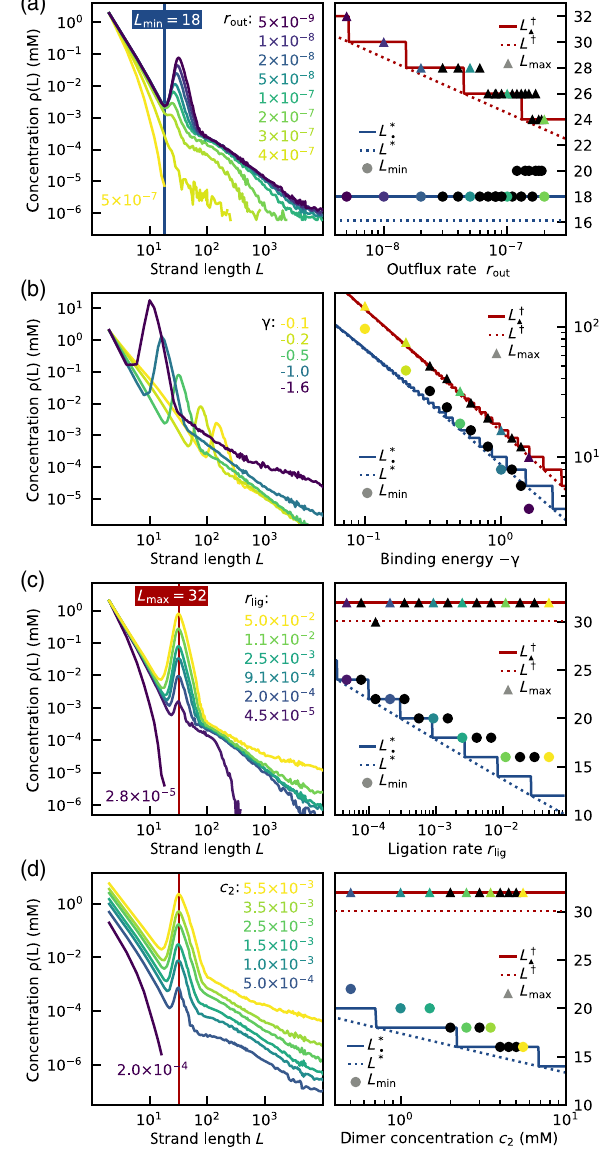
FIG. 11. Probing the parameter space of the dimer-only model. Left-hand column: stationary length distributions. Right-hand column: comparison of the observed values L predictions for L (cid:1) and L † via Eqs. (13) and (15). Variable parameters are (a) the outflux rate r binding energy per nucleotide γ , (c) the bare ligation rate r (d) the concentration of chemostated single-stranded dimers c 2